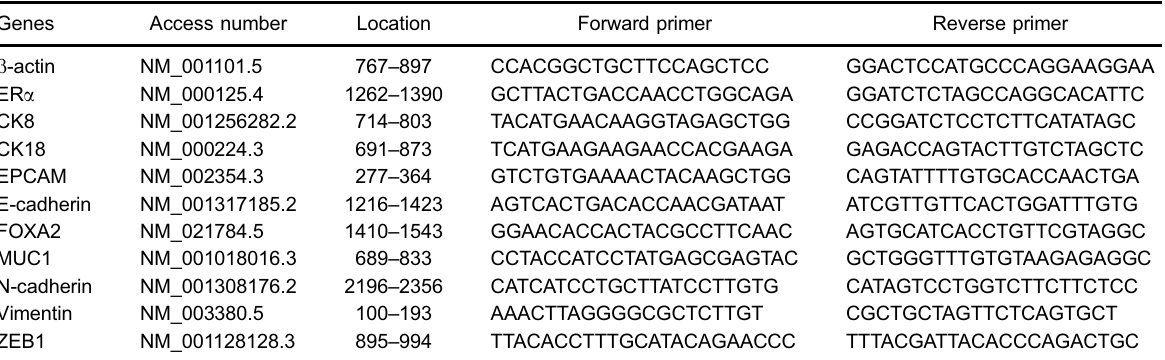
Table 1 . Primer sequences used for qRT-PCR